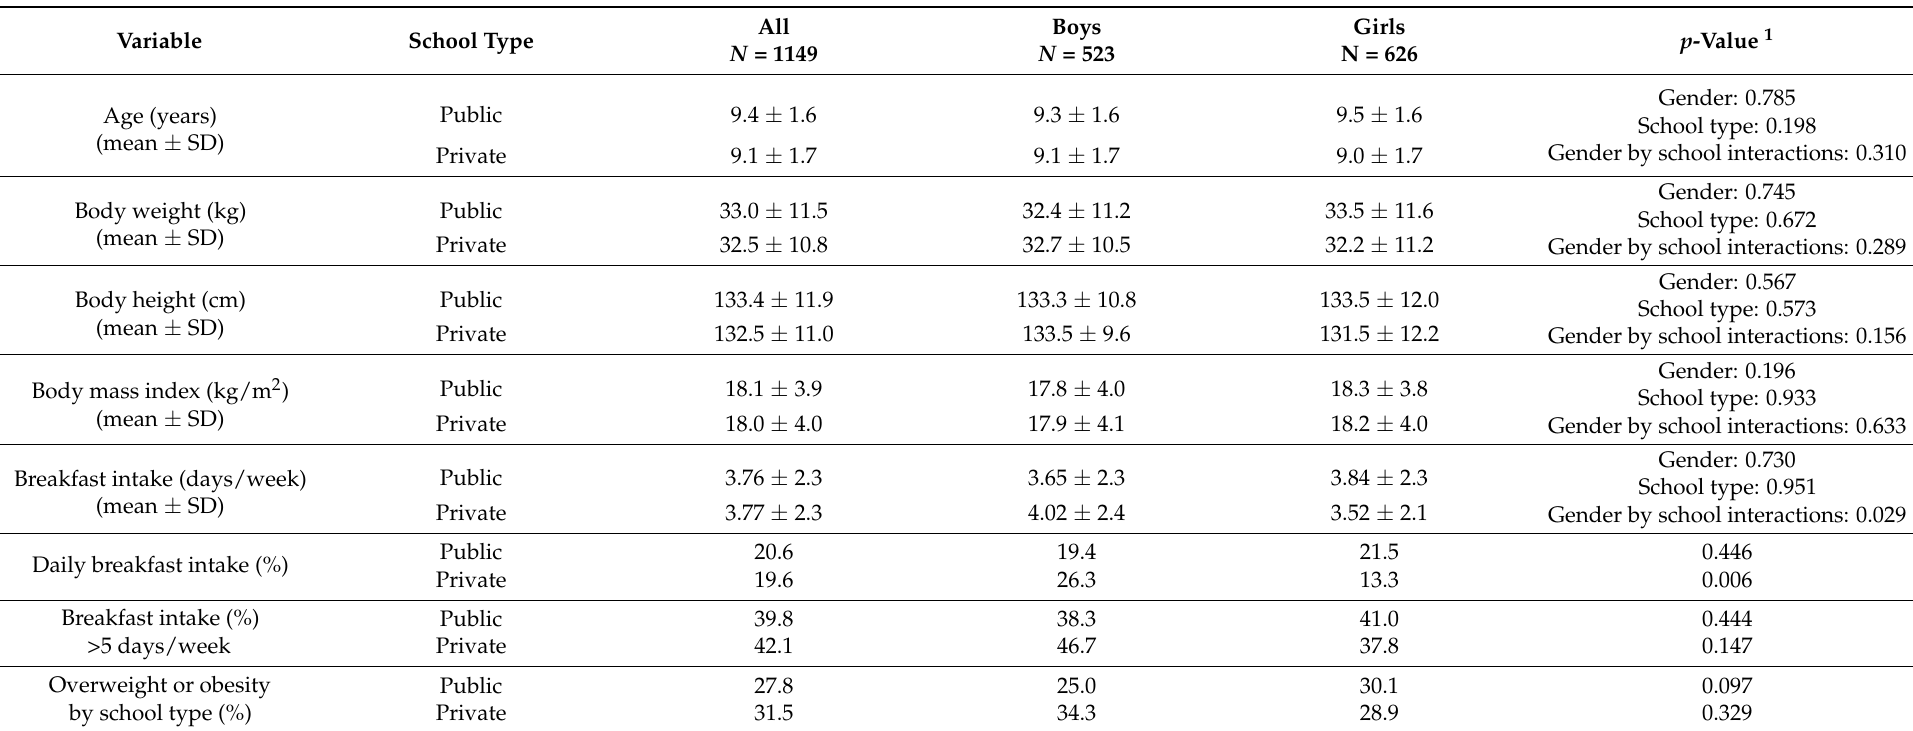
Table 1. Characteristics of the participants relative to gender and type of